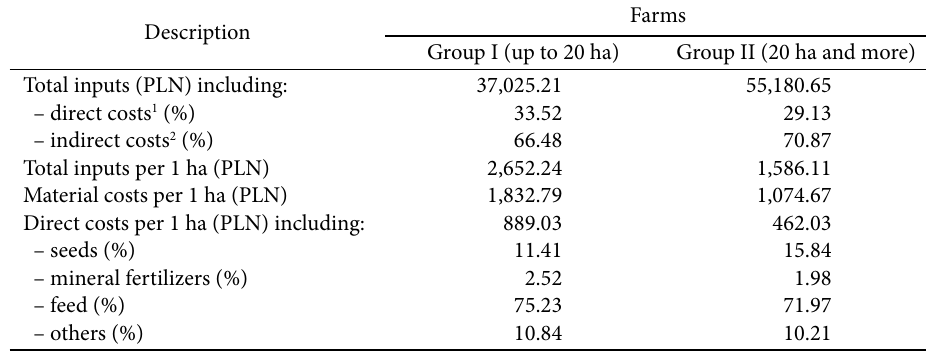
Table 5. Selected information about total inputs of organic farms in the years 2008–2012 (per farm) Farms Description Group I (up to 20 ha) Group II (20 ha and